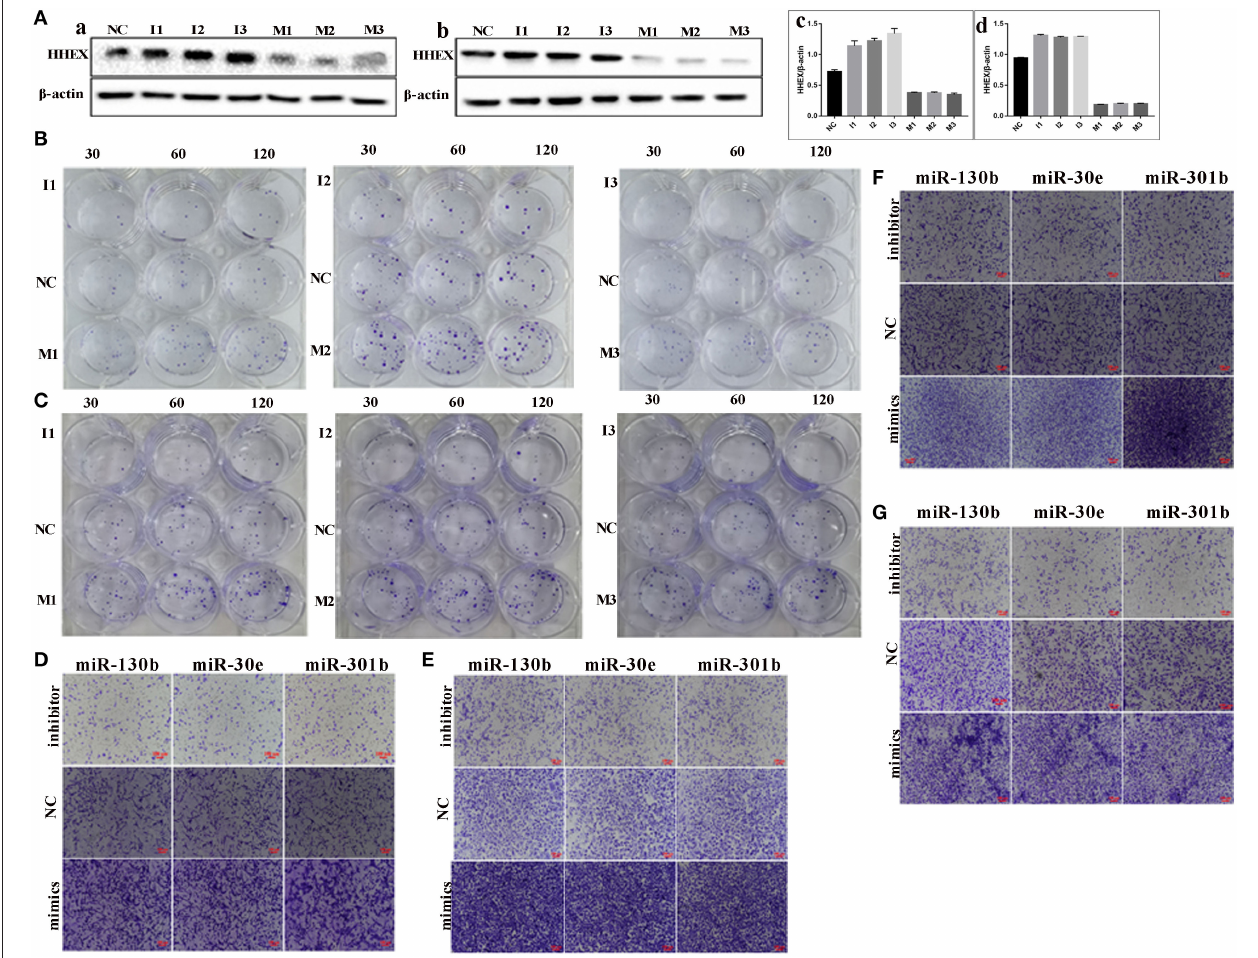
FIGURE 7 | miRNAs negatively regulated HHEX and influenced the migration, invasion, and proliferation ability in MDA-MB-231 and BT-549. (A) HHEX expression of MDA-MB-231 and BT-549 transfected with and without miRNA inhibitors, mimics. (a) HHEX expression in MDA-MB-231. (b) HHEX expression in BT-549. (c) Histogram showed the quantitative result of the HHEX expression in MDA-MB-231 with different treatments. (d) Histogram showed the quantitative result of the HHEX expression in BT-549 with different treatments. (B) Plate clone formation experiment was used to compare the proliferation ability of MDA-MB-231 transfected with and without miRNA inhibitors, mimics. (C) Plate clone formation experiment was used to compare the proliferation ability of BT-549 transfected with and without miRNA inhibitors, mimics. (D) Transwell migration assay showed the cells migration capacity of MDA-MB-231 transfected with and without miRNA inhibitors, mimics (100 × ). (E) Transwell migration assay showed the cells migration capacity of BT-549 transfected with and without miRNA inhibitors, mimics (100 × ). (F) Transwell invasion assay of MDA-MB-231 cells transfected with and without miRNA inhibitors, mimics (100 × ). (G) Transwell invasion assay of BT-549 cells transfected with and without miRNA inhibitors, mimics (100 × ). NC, normal control; M1, miR-130b mimics; M2, miR-30e mimics; M3, miR-301b mimics; I1, miR-130b inhibitor; I2, miR-30e inhibitors; I3, miR-301b